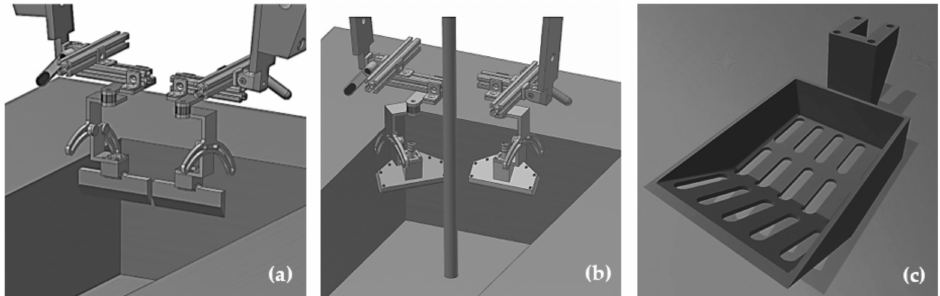
Figure 3. Designed zinc ash skimming systems: ( a ) Mechanical skimming system; ( b ) Gas-based skimming system; and ( c ) designed extraction system.